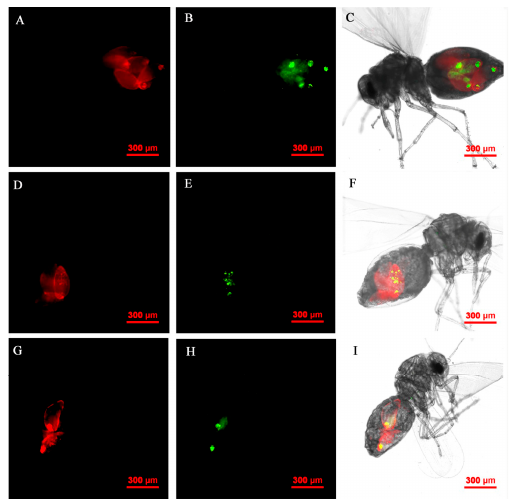
Figure 9. FISH visualization of Wolbachia and Ricke tt sia in adult stages of B. tabaci . Localization of symbiotic bacteria Ricke tt sia (red) and Wolbachia (green) in adult stages of B. tabaci . Ricke tt sia fl uores- of symbiotic bacteria Rickettsia (red) and Wolbachia (green) in adult stages of B. tabaci . Rickettsia cence ( A , D , G ) and Wolbachia fl uorescence ( B , E , H ) are displayed in dark fi eld; W olbachia and Ricke tt - fluorescence ( A , D , G ) and Wolbachia fluorescence ( B , E , H ) are displayed in dark field; W olbachia and sia fl uorescence ( C , F , I ) is displayed in bright fi eld. Rickettsia fluorescence ( C , F , I ) is displayed in bright